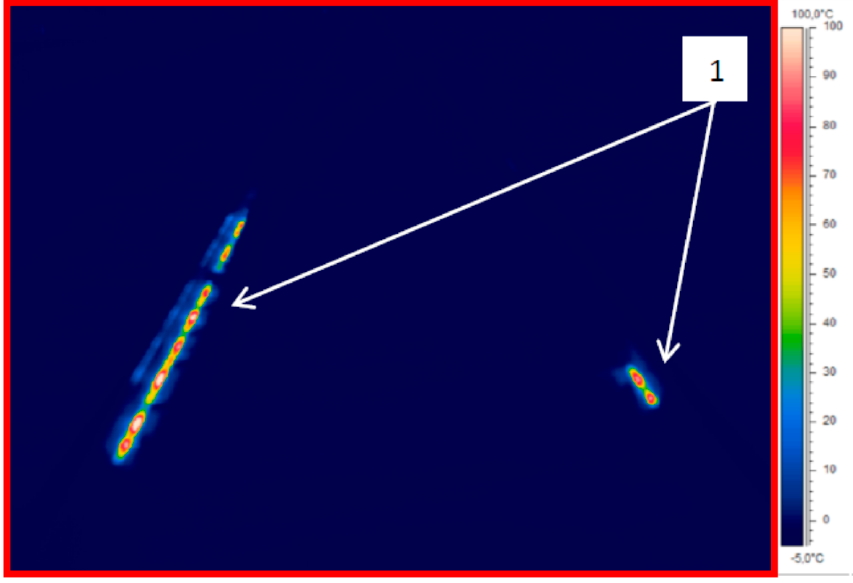
Figure 9. Thermogram IR_0145—rain900 colour palette (source: authors).